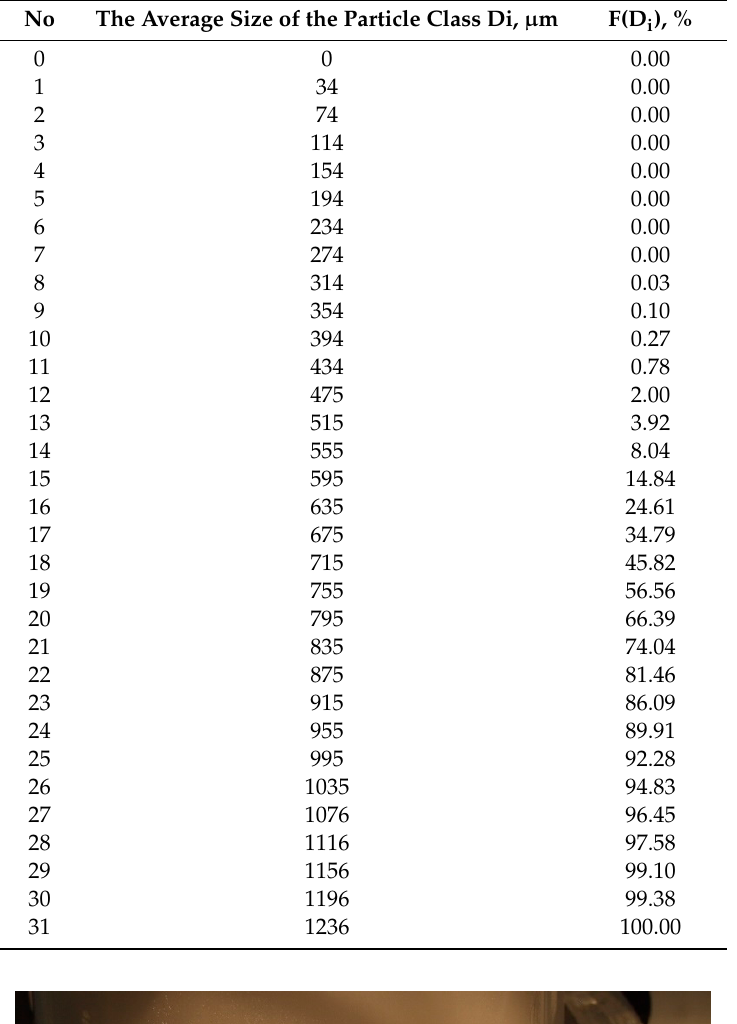
Table 1. The particle size distribution of limestone feed.